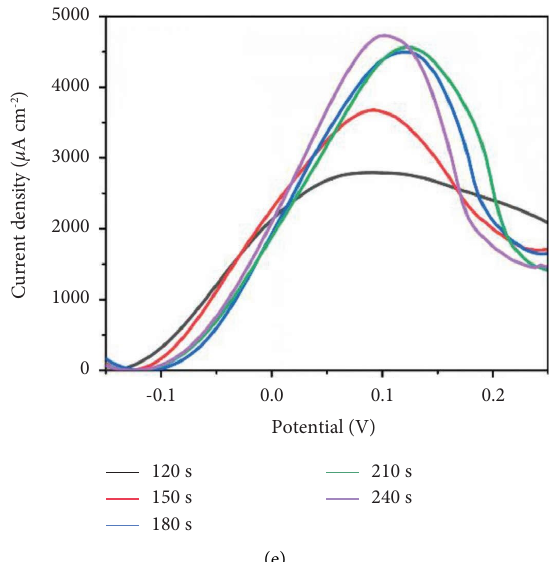
Figure 3: SWASV responses of the MnO 2 /SP-modifed SPEs (a) with the diferent loading mass of MnO 2 /SP, (b) with the diferent contents of SP carbon, and (c) with the diferent loading mass of Nafon. SWASV responses of the MnO 2 /SP-modifed SPEs (d) at the diferent deposition potentials for 180s and (e) for the diferent deposition times at the deposition potential of − 1V in 0.1M NaAc-HAc (pH 5.0) solution containing 10nM CuSO 4